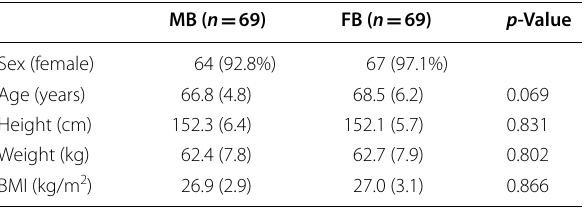
Table 2 Demographic data of patients in the two implant groups